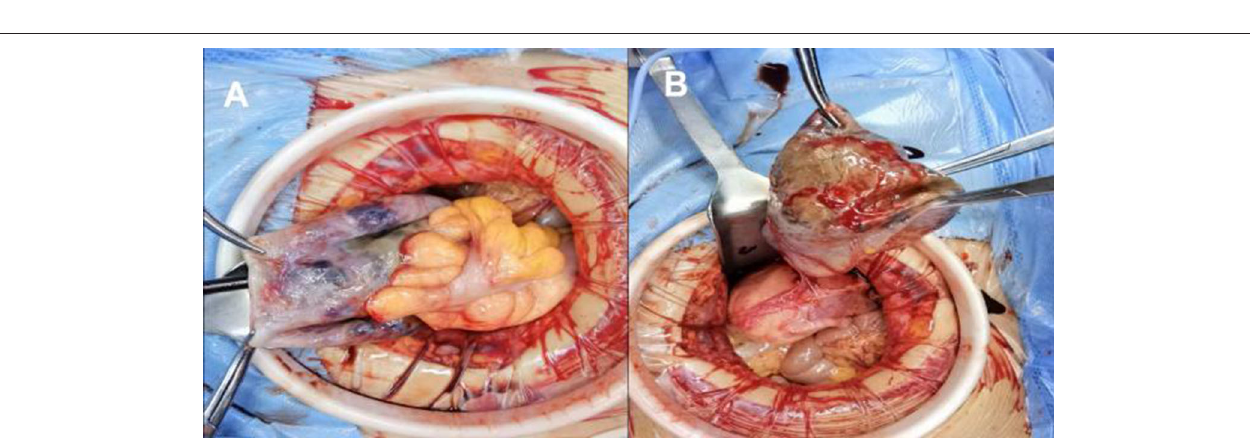
FIGURE 3 | (A,B) Intraoperative pictures of